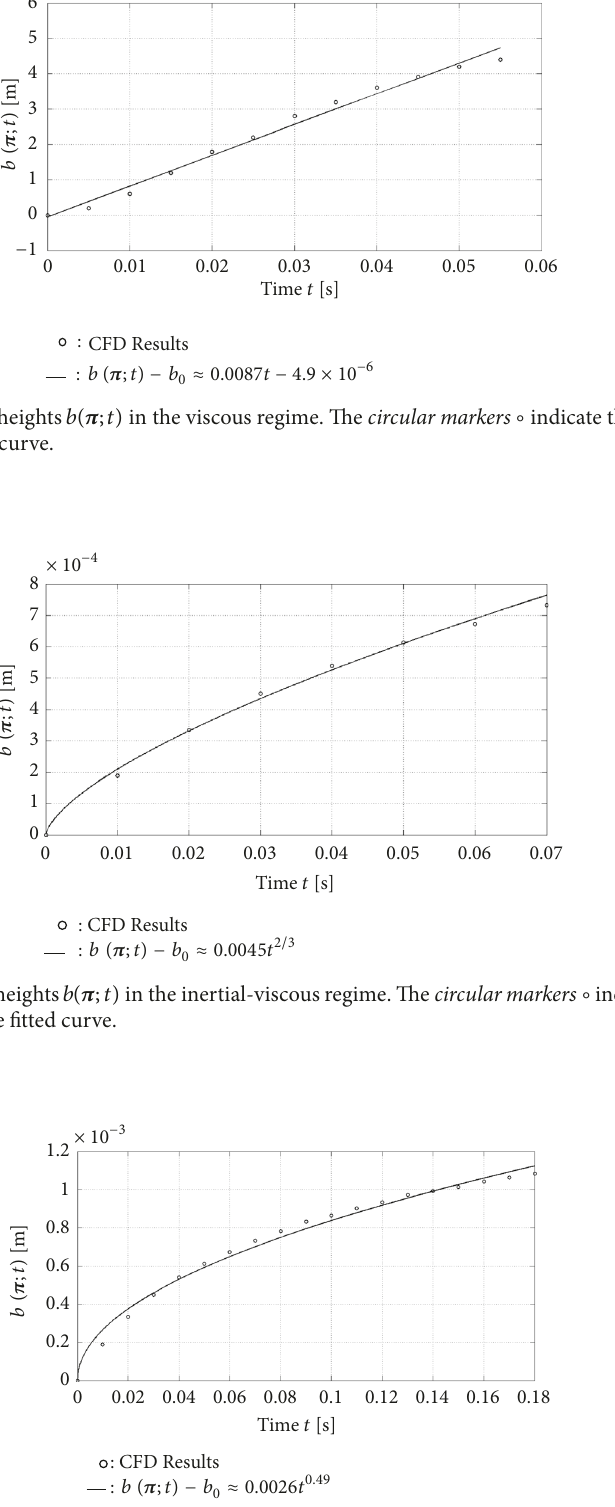
Figure 7: Time evolution of the neck heights 𝑏( 𝜋 ; 𝑡) in the inertial regime. The circular markers ∘ indicate the numerical experiment results and the solid line represents the fitted